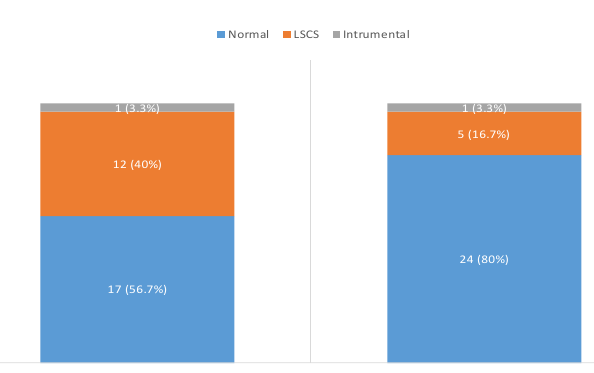
Fig 1 : Distribution of cases according to the mode of